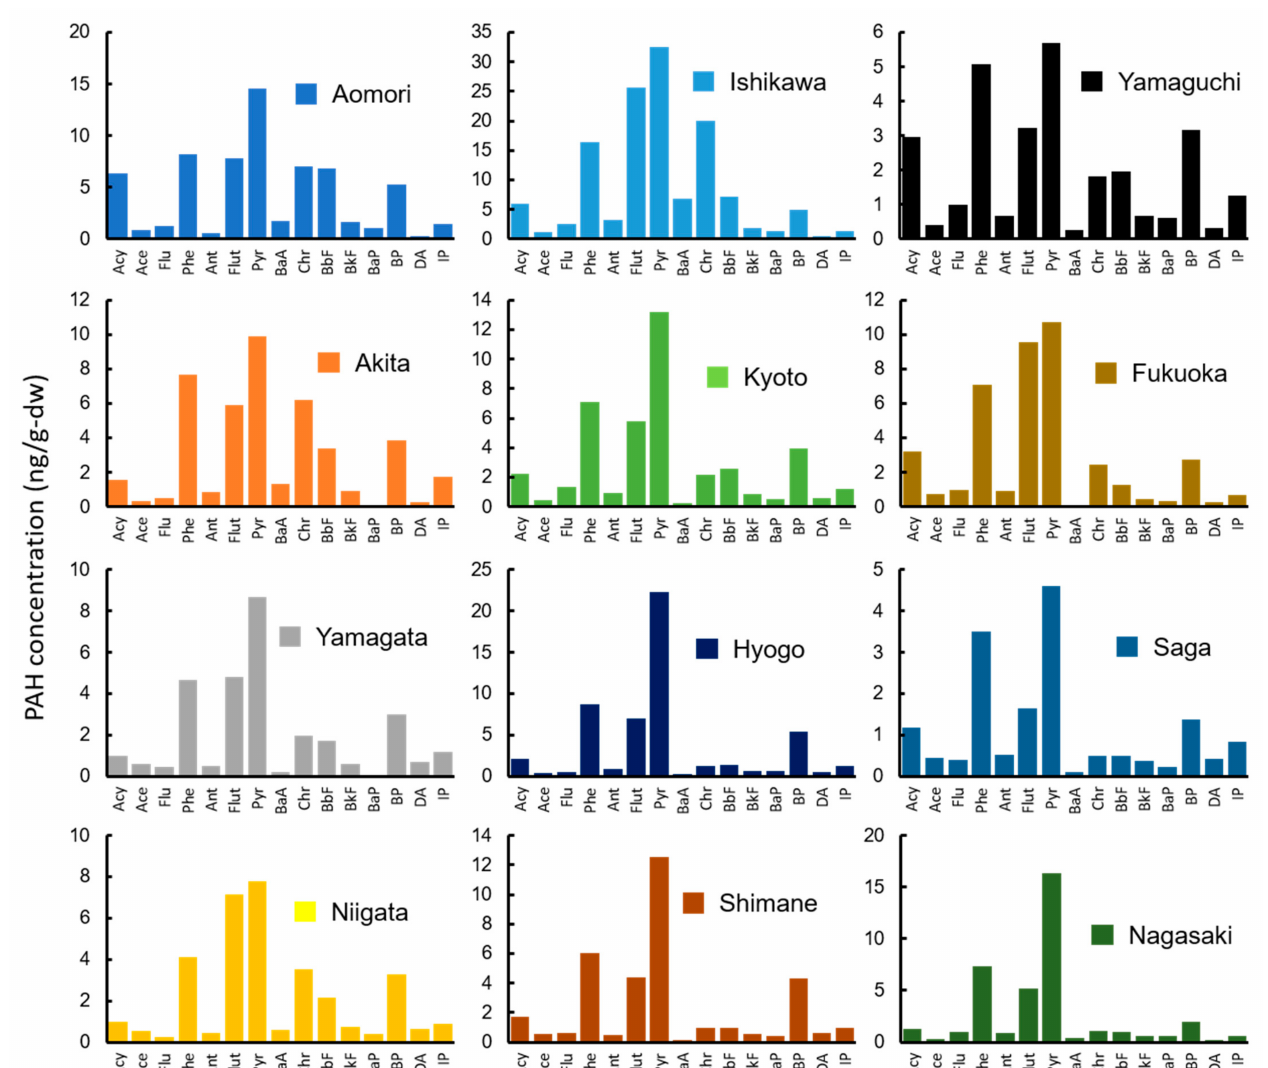
Figure 3. Concentrations of 15 PAHs in mussels (ng/g-dw) collected from 12 sampling